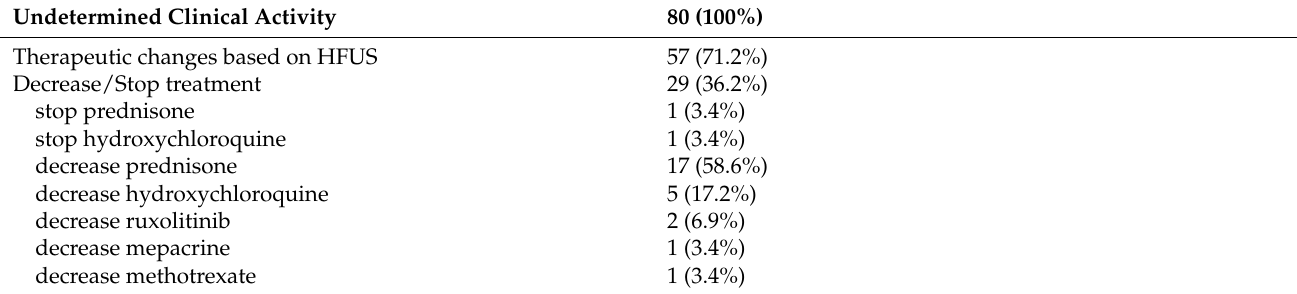
Table 3. Therapeutic modifications supported by high-resolution Doppler ultrasound results in patients with undetermined clinical